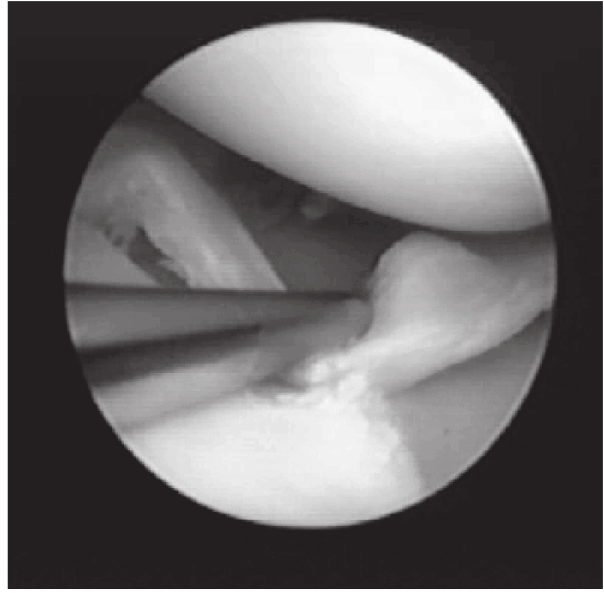
Figure 2 - Arthroscopy of knee showing a “pail-handle” meniscal